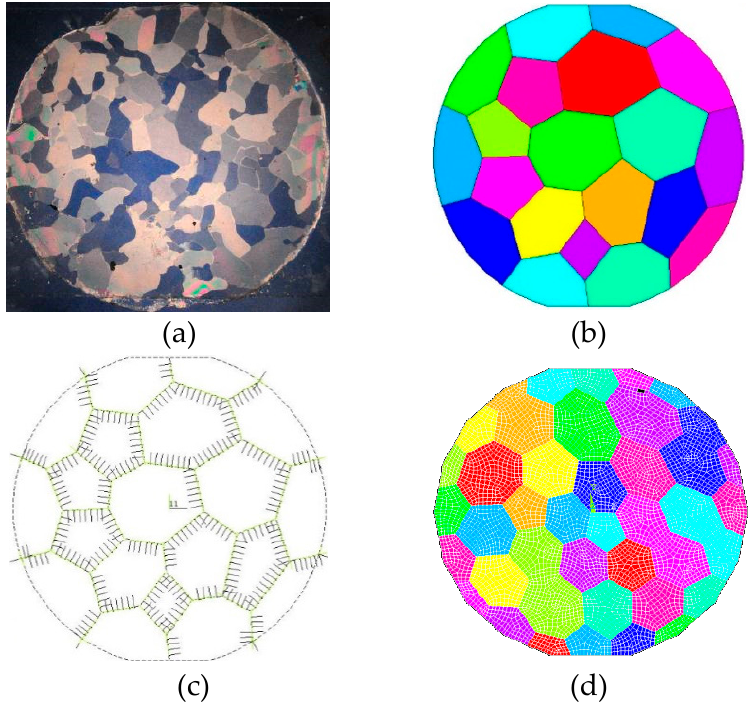
Figure 8. The finite element model of river ice microstructure: ( a ) a typical sample diagram of the microstructure of Yellow River ice; ( b ) a structure diagram of the numerical model; ( c ) a spring unit diagram of ice crystal boundaries; ( d ) a sketch map of the whole model.